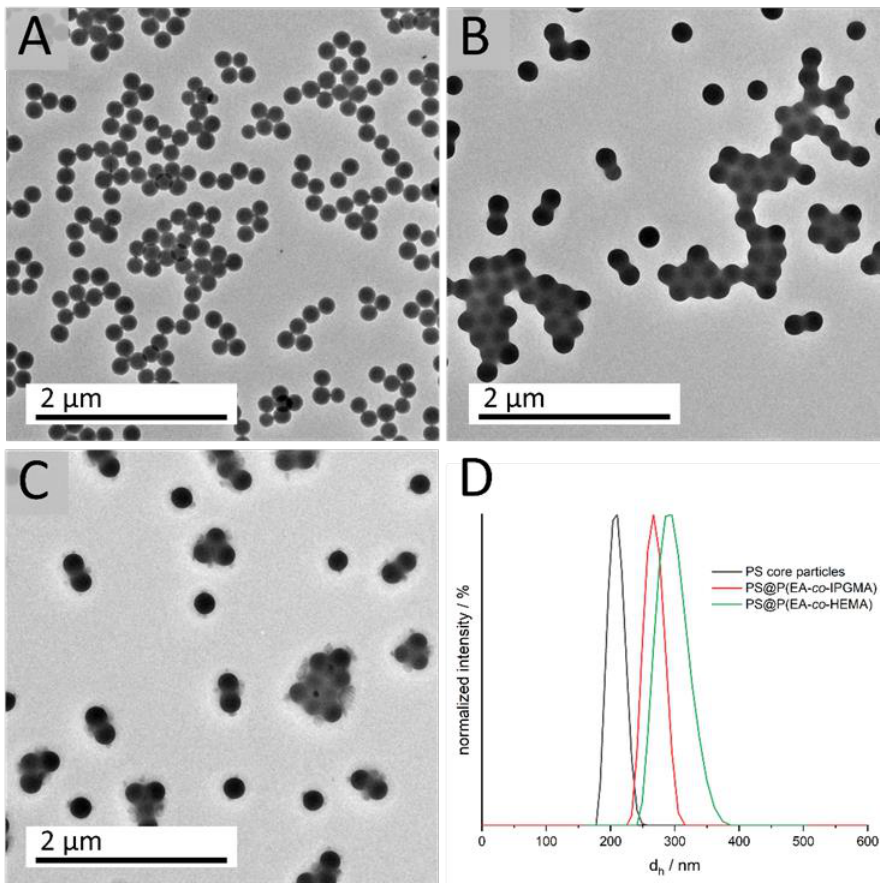
Figure 2. TEM images of ( A ) PS core particles, ( B ) PS@P(EA- co -IPGMA) particles, ( C ) PS@P(EA- co - HEMA) particles, and ( D ) DLS measurements of the core and the final CIS particles.